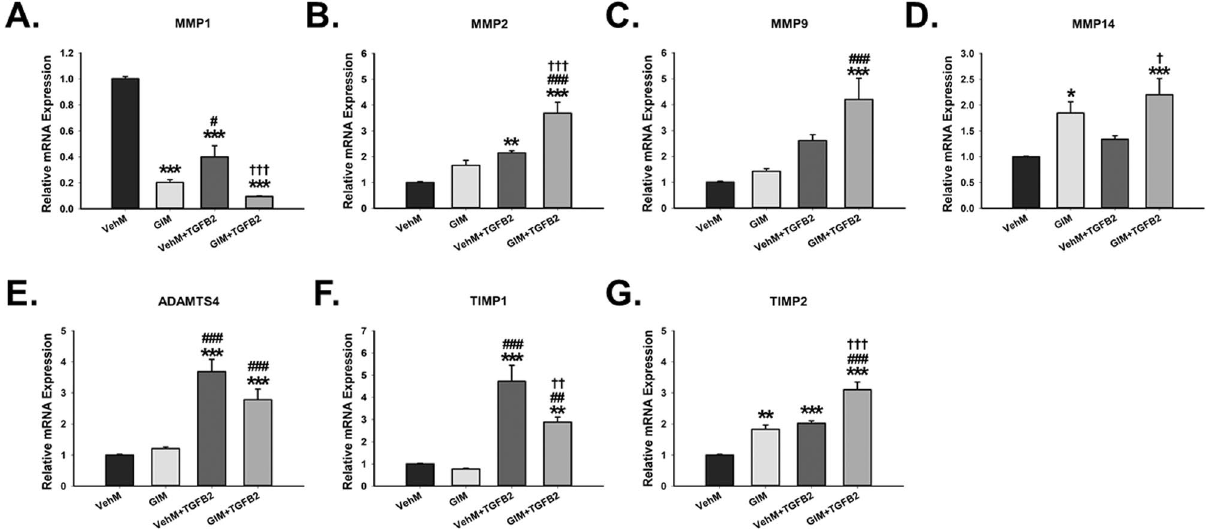
Figure 7. GIMs modulate specific genes responsible for ECM turnover with or without exogenous TGFβ2 in hTM cells. Primary hTM cells were cultured in the presence or absence of 100 nM dexamethasone for 4 weeks in complete growth media. Cells were subsequently removed using 20 mM ammonium hydroxide solution to obtain GIMs and vehicle control matrices (VehMs). Same strain, fresh primary hTM cells were then seeded on these matrices with or without exogenous 5 ng/ml TGFβ2 in 1% fetal bovine serum growth media for 7 days. RNA was extracted for reverse transcription and qPCR. GAPDH was used as an internal control for normalization. Bar graph for the gene expression of (A) Matrix metalloproteinase 1 (MMP1), (B) MMP2, (C) MMP9, (D) MMP14, (E) A disintegrin and metalloproteinase with a thrombospondin motif 4 (ADAMTS4), (F) Tissue inhibitor of matrix metalloproteinase 1 (TIMP1), and (G) TIMP2. Columns and error bars ; means and standard error of mean (SEM). One-way ANOVA with the Tukey pairwise comparisons post hoc test was used for statistical analysis. (n = 4 biological replicates. *p < 0.05, **p < 0.01, ***p < 0.001 for the group of interest versus control, VehM. # p < 0.05, ## p < 0.01, ### p < 0.001 for the group of interest versus GIM. † p < 0.05, †† p < 0.01, ††† p < 0.001 for VehM + TGFβ2 versus GIM + TGFβ2). hTM, human trabecular meshwork. GAPDH, Glyceraldehyde 3-phosphate